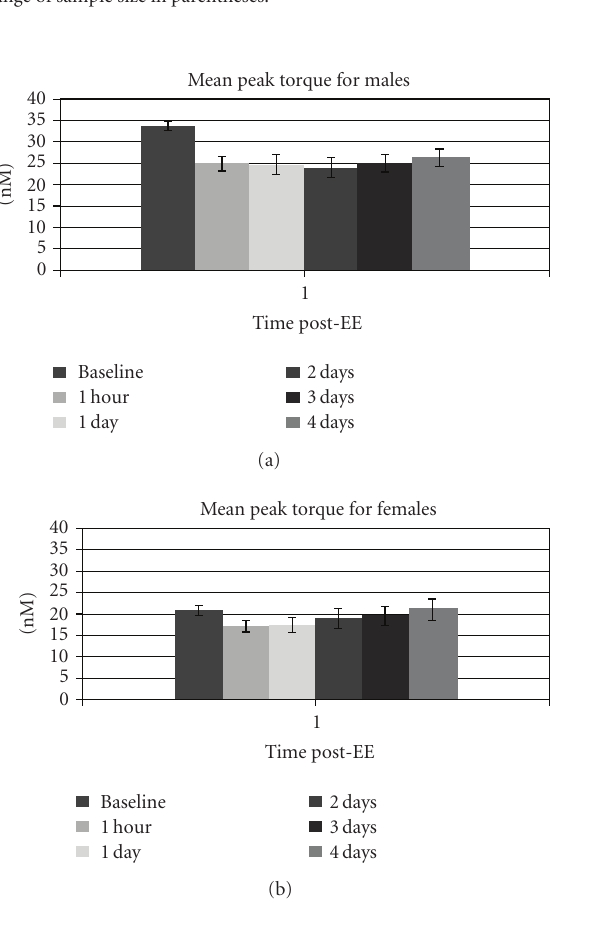
Figure 3: Plot of mean pain intensity rating (scale 0–100) during unloaded movement through full range of motion of the elbow versus serum 25-hydroxyvitmamin D (25OHD) concentrations (nmol/L) in female participants ( N = 21). Pain rating obtained 2 days after eccentric exercise protocol; 25OHD serum samples obtained within one week of exercise. Linear regression R -squared value = 0.07, P value = . 24. Plot, R -squared, and P value are representative of other pain and muscle strength variables examined in both